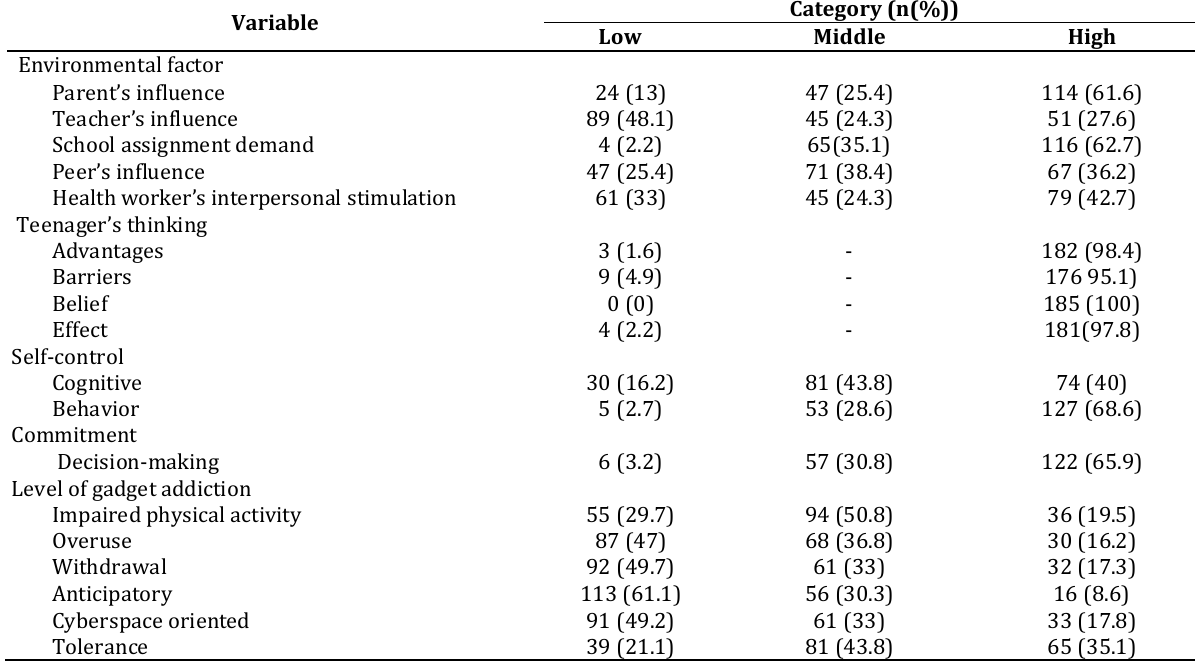
Table 4. Distribution of Environmental Factor, Teenager’s Thinking, Self -Control, Commitment,